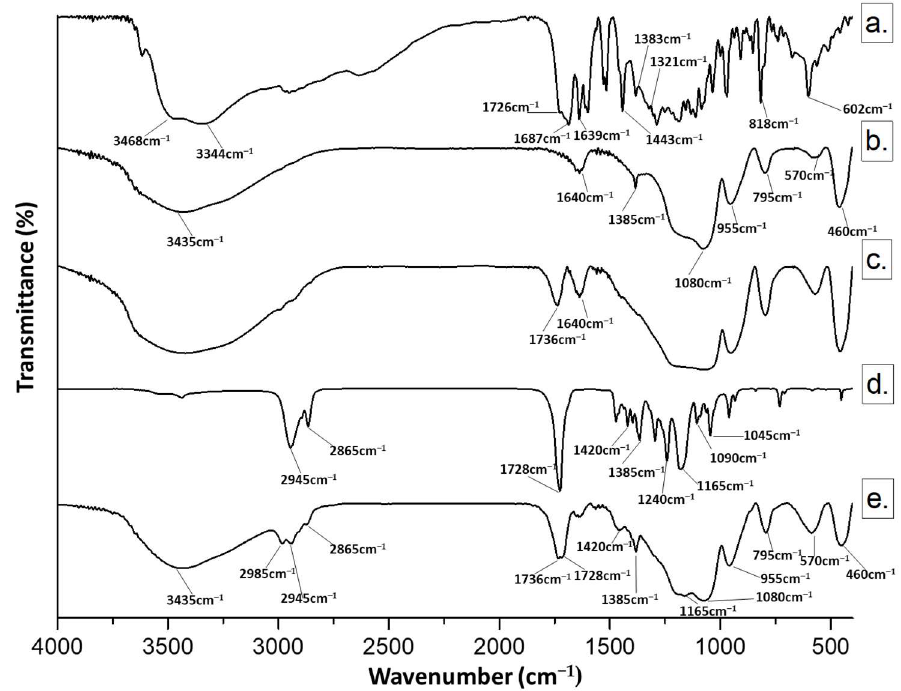
Figure 1. Representative FTIR spectra of ( a ) CGA (C); ( b ) pure SiO 2 (S); ( c ) SC15; ( d ) pure PCL (P); ( e ) SC15P24. The number indicates the wt% of CGA and/or PCL in hybrids. When chlorogenic acid was added to the silica matrix (Curve c), a red shift (+10 cm −1 )